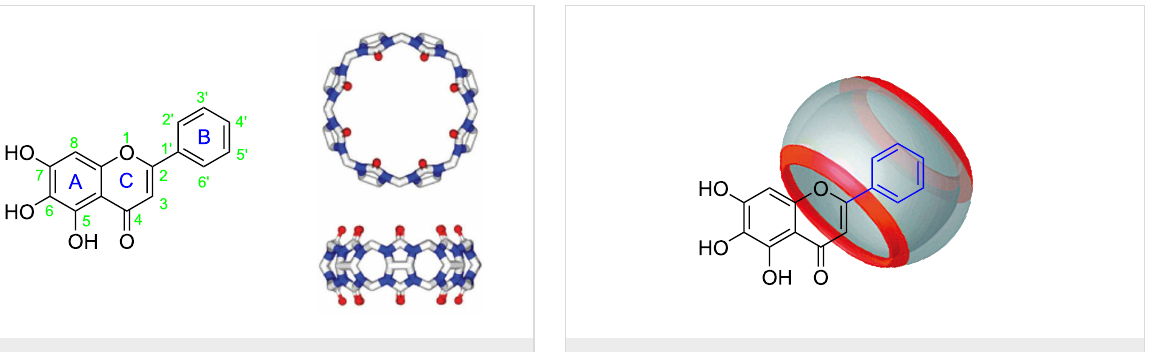
tions of host–guest interactions between BALE and Q[8] in an aqueous solution using 1 H NMR, UV–vis and IR spectroscopy, and DTA. The properties of the BALE–Q[8] inclusion complex, such as stability, solubility, in vitro antioxidant activity and release performance were studied by means of UV–vis spec- troscopy.